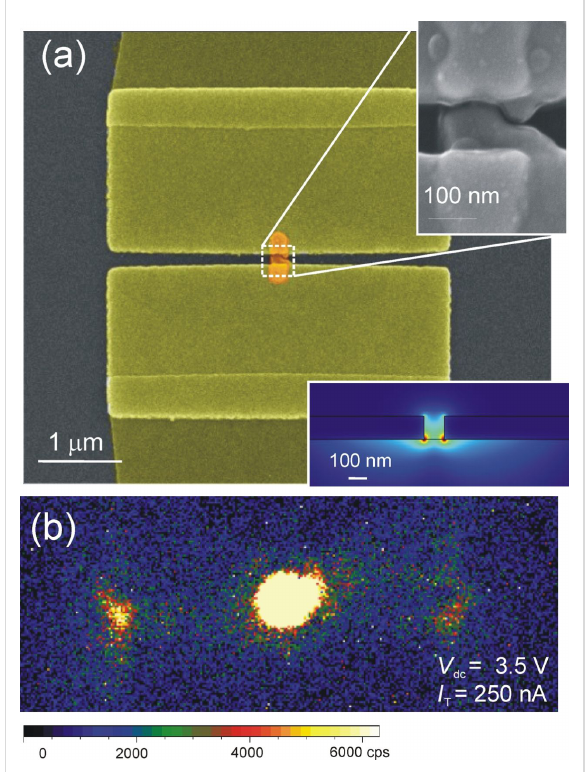
Figure 7: (a) Colorized image of the optical tunneling gap antenna (orange) integrated inside a slot waveguide formed by two Au pads separated by 130 nm. Upper inset: close-up SEM image of the junc- tion after electromigration. Lower inset: calculated distribution of the norm of the electric field in the 130 nm × 150 nm slot waveguide. (b) False-color CCD image of the distribution of light when the antenna is biased at V dc = 3.5